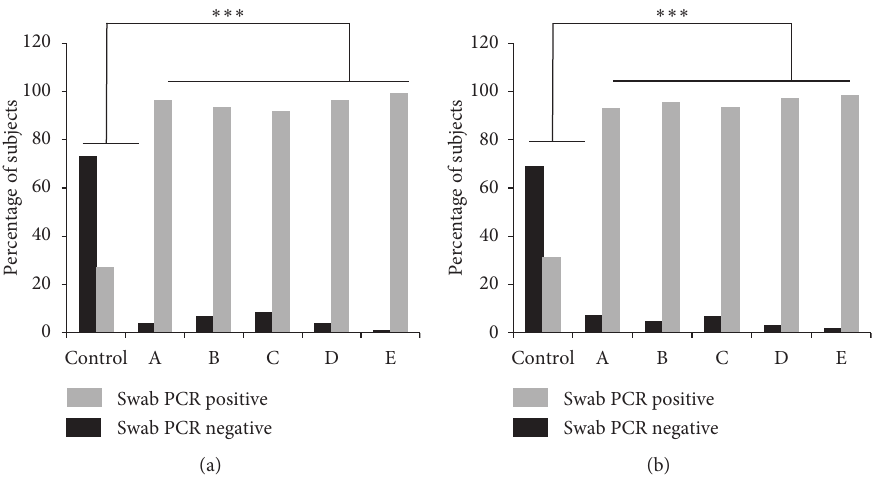
Figure 2: The RT-PCR analysis results of all subjects in the Control and treatment groups of A–E on day 3 (a) and day 7 (b) during the study period ( ∗∗∗ p < 0 . 0001 compared with the Control). Control group: 1 × 500mg azithromycin per day; Group A: 2 × 200/50 mg lopinavir/ ritonavir+1 × 500mg azithromycin per day; Group B: 2 × 200/50mg lopinavir/ritonavir +2 × 100mg doxycycline per day; Group C: 2 × 100 mg hydroxychloroquine +1 × 500mg azithromycin per day; Group D: 2 × 400/100 mg lopinavir/ritonavir+1 × 500mg azithromycin per day; Group E: 2 × 400/100mg lopinavir/ritonavir+2 × 100mg doxycycline per